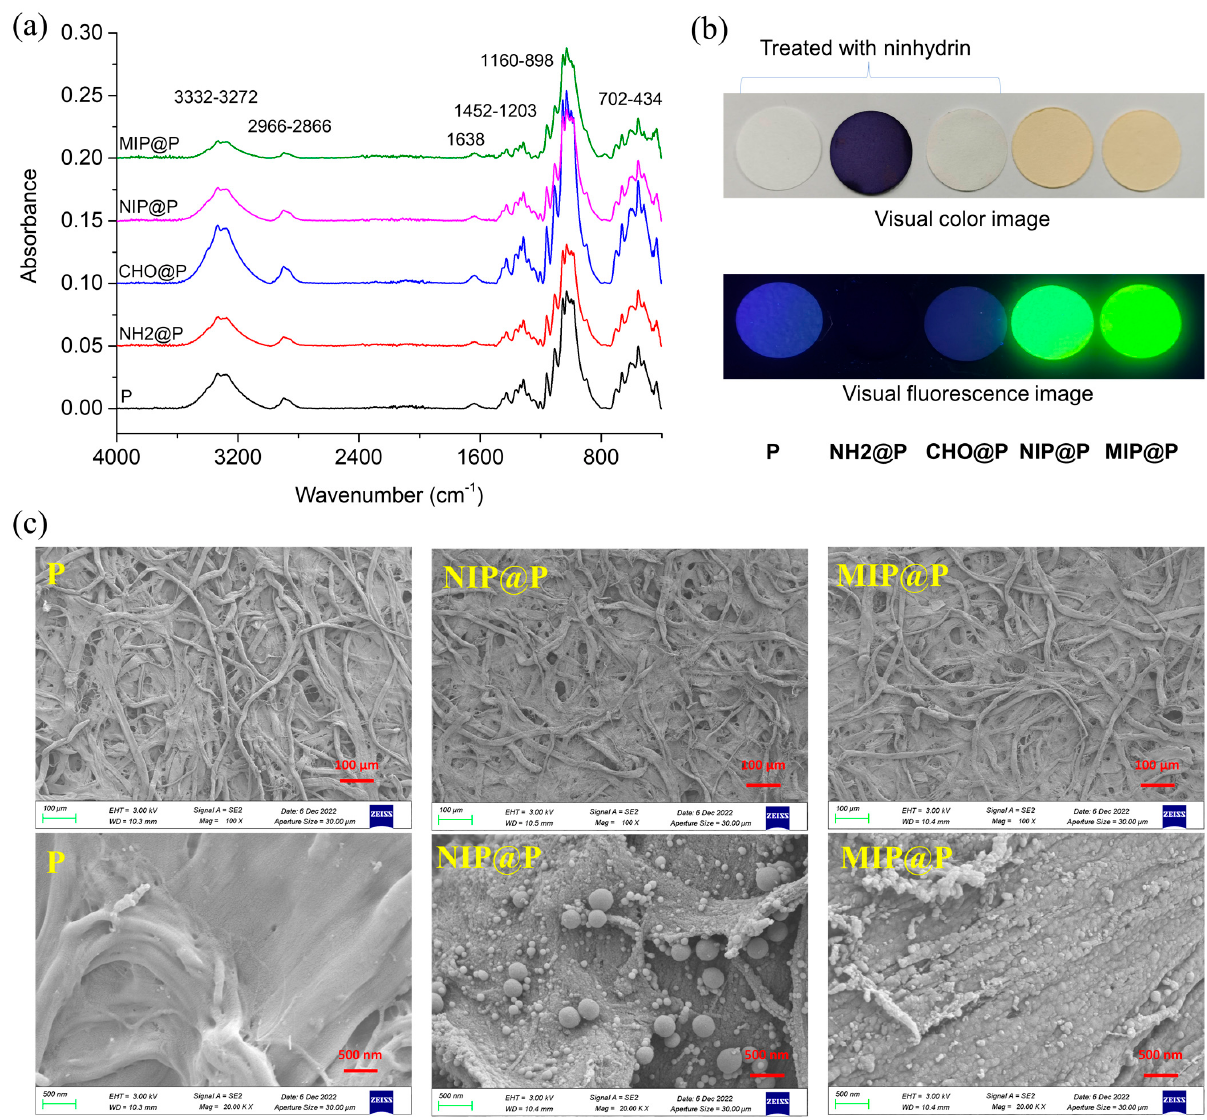
Figure 3. ( a ) IR spectra of P, NH2@P, CHO@P, NIP@P and MIP@P; ( b ) Visual color and